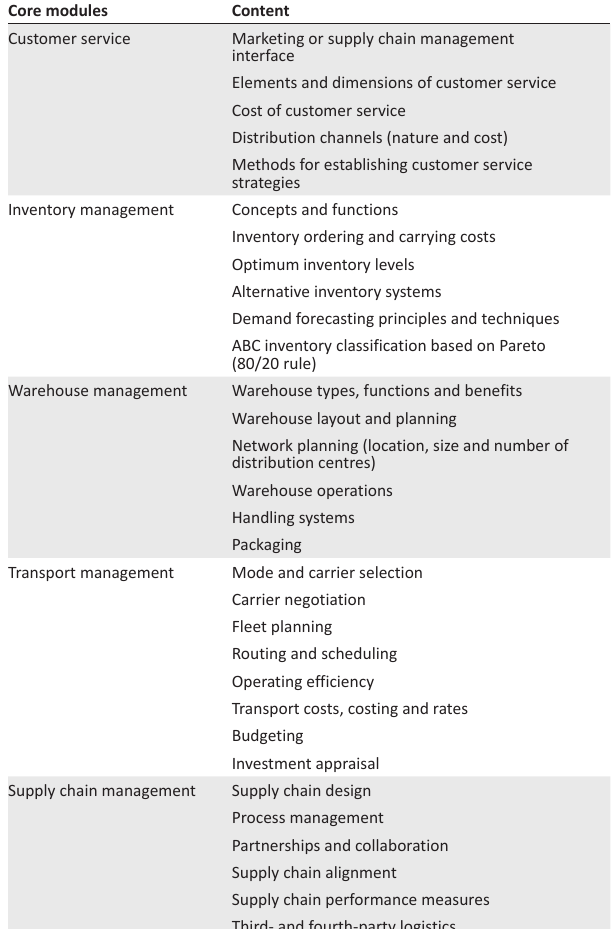
TABLE 3: Programme core modules and content. Core